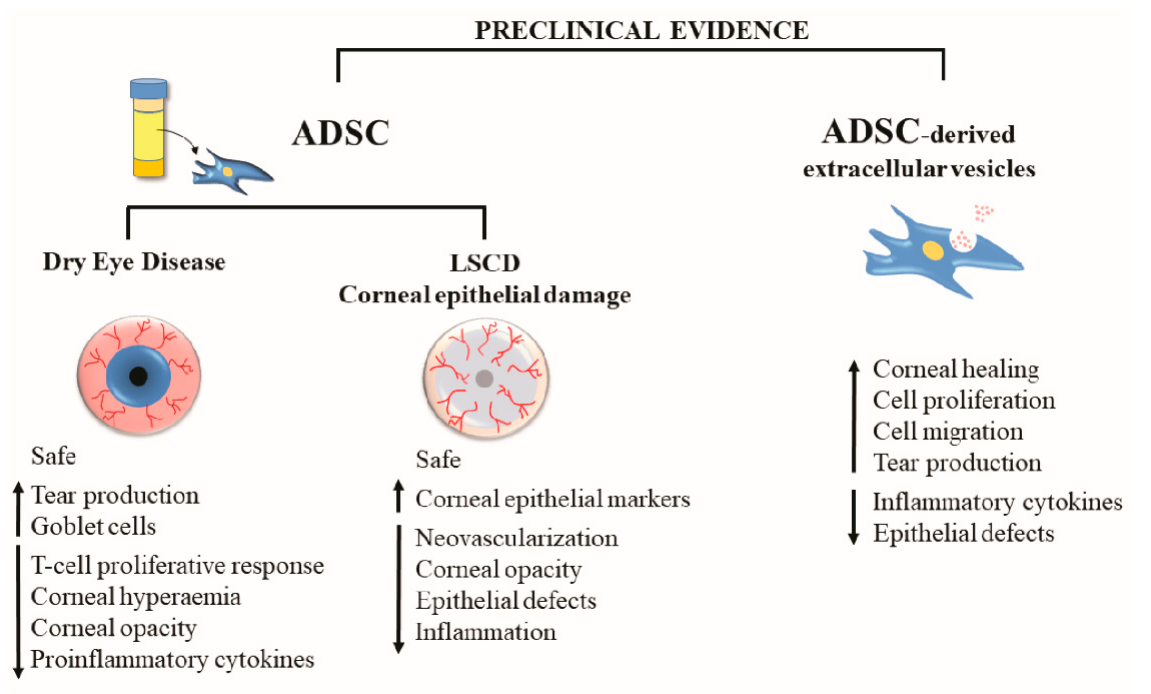
Figure 1. Preclinical evidence of the effects of ADSC-based therapy for the treatment of corneal epithelial damage (ADSC: adipose tissue-derived mesenchymal stem cells; LSCD: limbal stem cell deficiency).